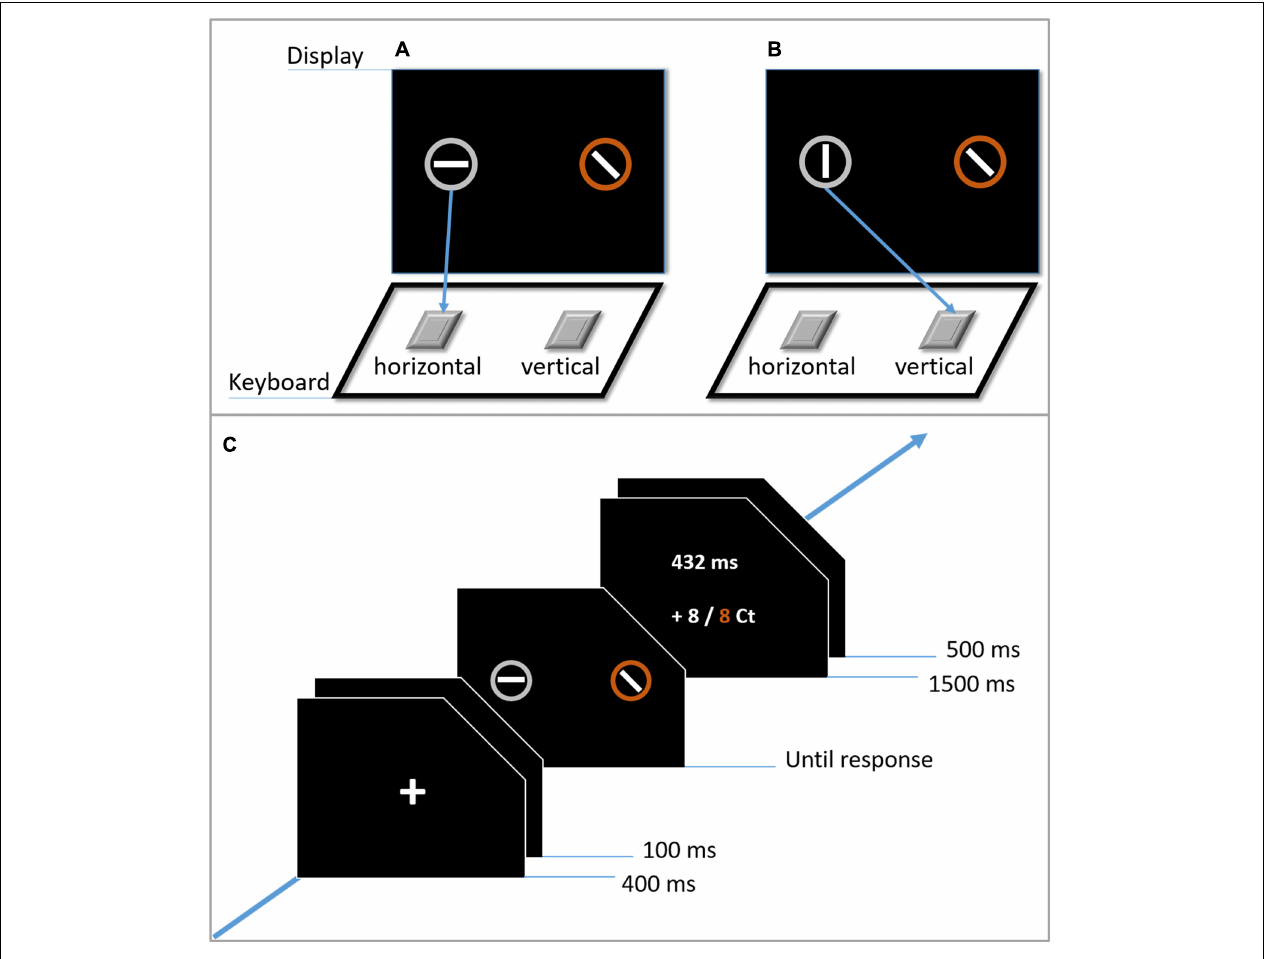
FIGURE 1 | Illustration of the congruent (A) and incongruent (B) condition in the Simon search task, as well as an example trial sequence in Experiment 1 (C)